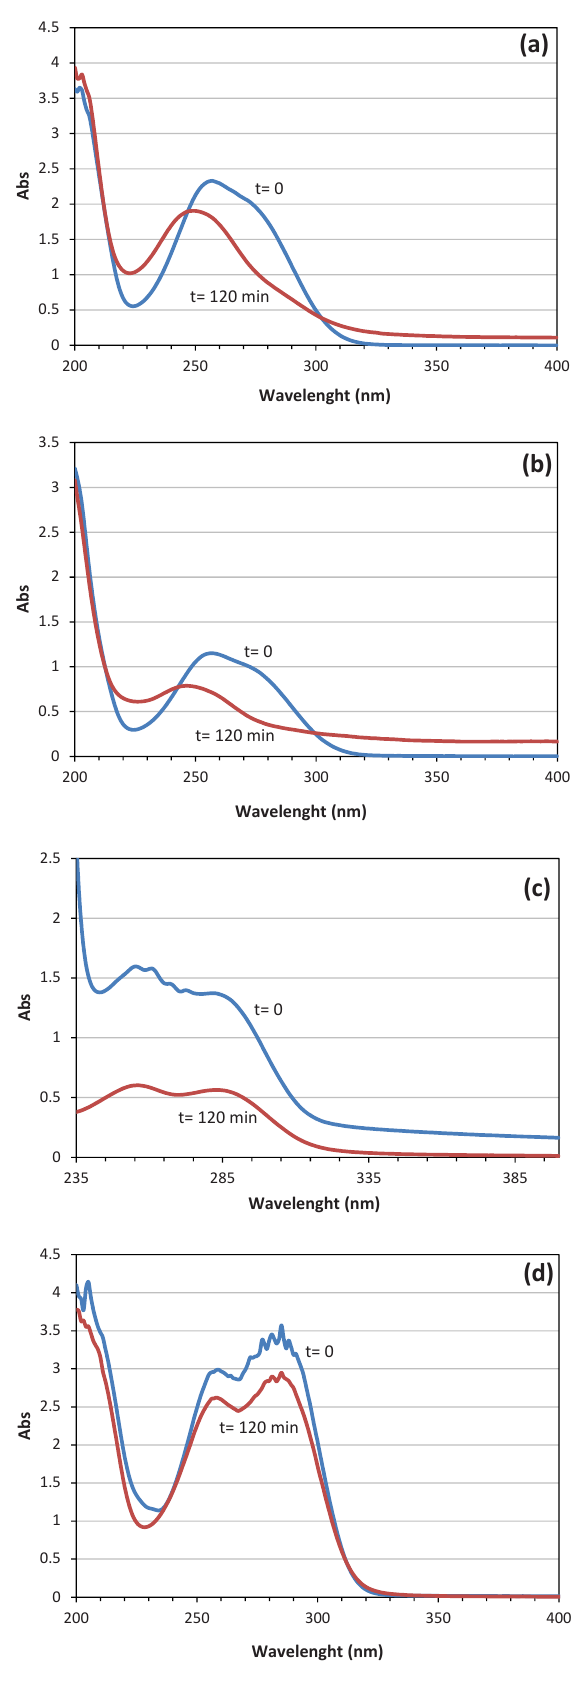
Fig. 6. Changes in the UV–Vis spectra of 30 mg/L aqueous solution of STZ in optimum conditions, during the photocatalytic process of UV/CdO with irradiation time 0-120 min: a) without catalyst, and with catalyst at b) pH= 11, c) pH= 3, and d) pH= 7.